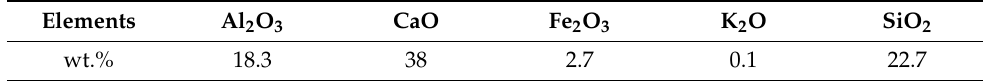
Table 1. XRF analysis of the major minerals in Subcoal™ ash.